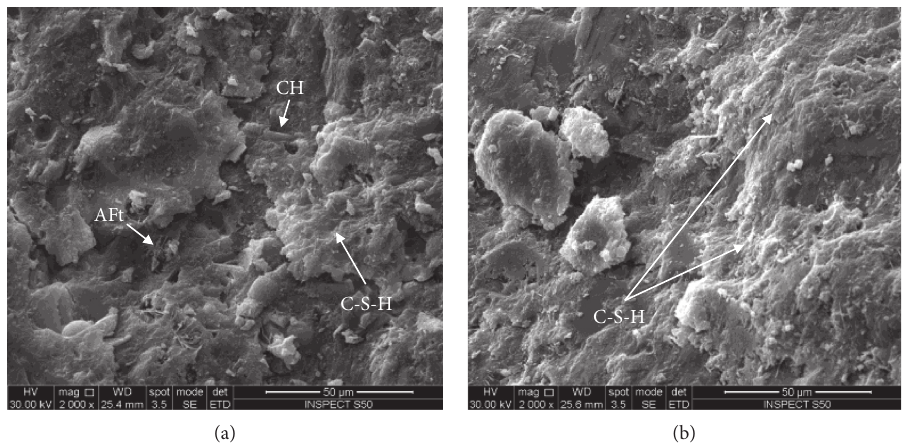
Figure 13: SEM maps of C3-7 under (a) 30 days and (b) 270 days of corrosion after 90 freezing-thawing